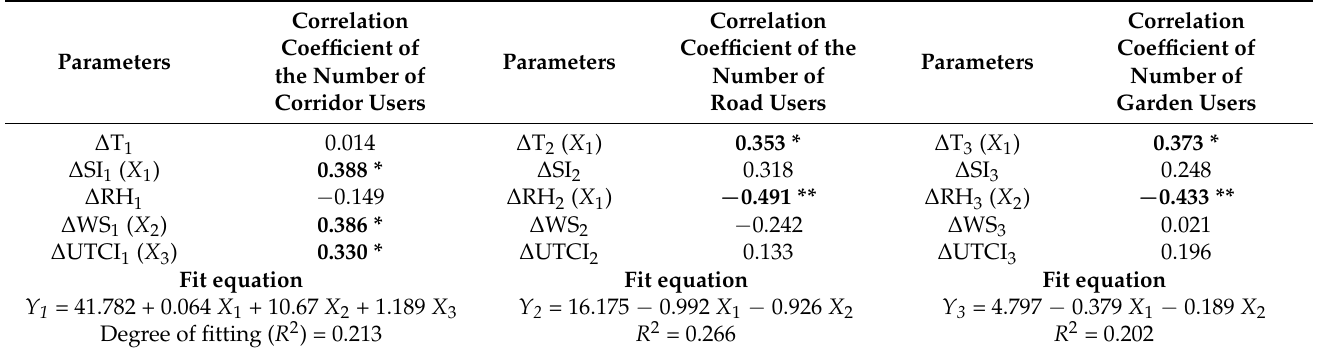
Table 4. Correlation between the user numbers and the microclimate differences of outdoor spaces in the nursing home.